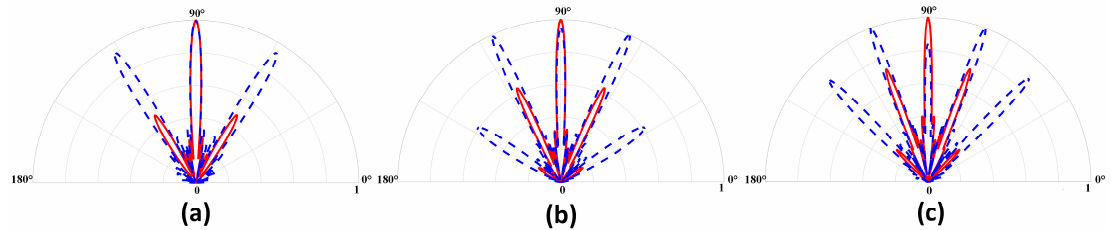
Figure 7. Comparison of simulated directivities between linear arrays of dipole sources and linear arrays of quadrupole sources with different ∆ l / λ values for five units. The blue and red lines are the results for the dipole and quadrupole arrays, respectively. ( a ) ∆ l / λ = 2, ( b ) ∆ l / λ = 2.5, and ( c ) ∆ l / λ = 3.